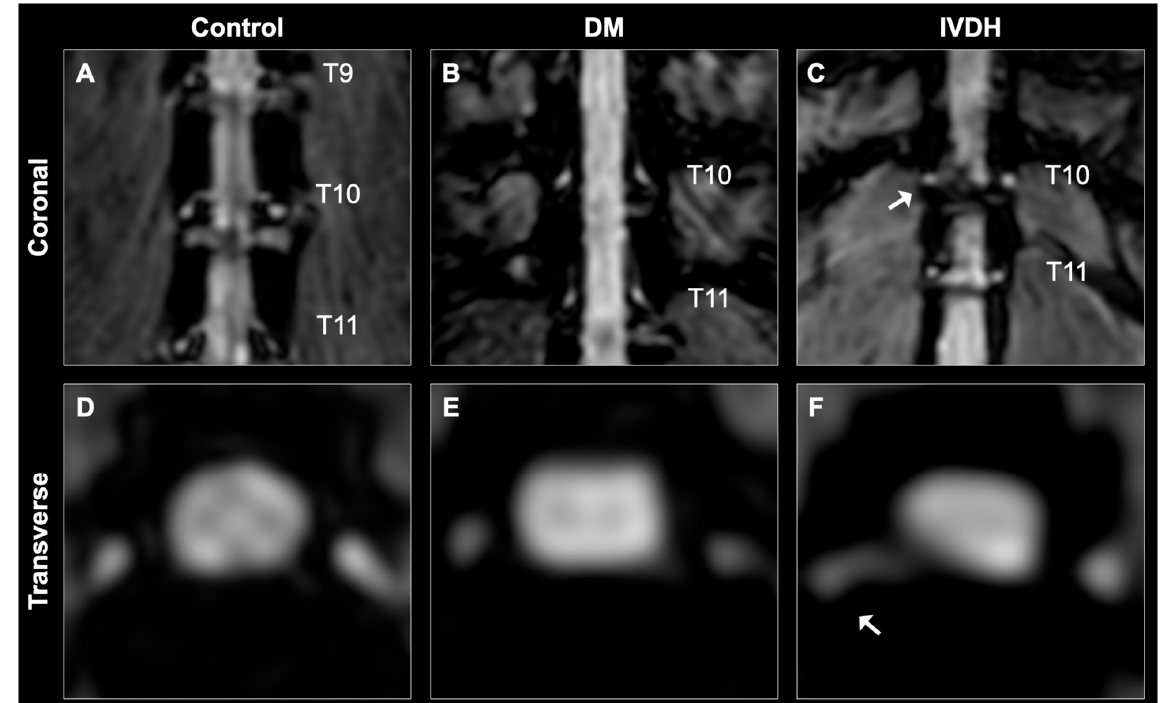
Figure 2. Dorsal root ganglion (DRG) and nerve root from a coronal and transverse magnetic resonance imaging data set. Volumes of DRG were measured from the images acquired by water-excitation sequence. Coronal images ( A – C ) showed the caudal thoracic spinal cord and nerve roots, and transverse images ( D – F ) showed T10 DRG. The volume of DRG was normal for a control dog (Dog #8) ( A , D ), and atrophied in a dog with degenerative myelopathy (Dog #12) ( B , E ). Volumetric atrophy of DRG (white arrow) was observed at the herniation site in a dog with inter vertebral disc herniation (Dog #38) ( C , F ). Table 2. Normalized DRG volumes among control, DM, and IVDH groups.